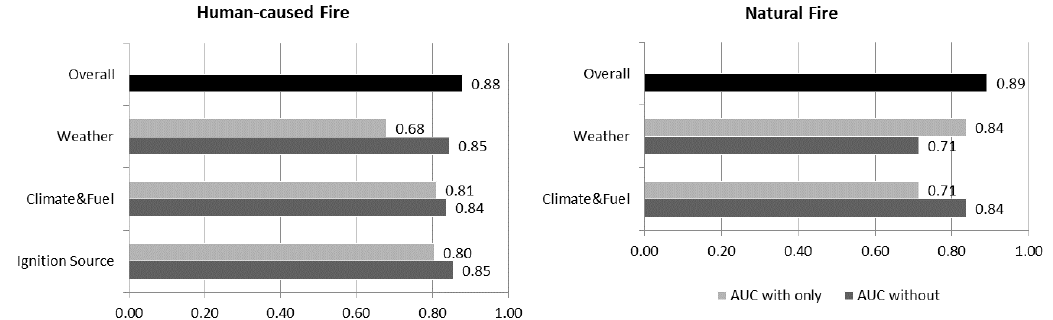
Figure 3. Jackknife estimations of variable importance for the best-performing models. Bars represent the area under the curve (AUC) of the receiver operator characteristic (ROC) curve. The AUCs of the full-models and the univariate models are denoted by black bars and light grey bars. The AUCs of models without the corresponding variables are represented by dark grey bars.